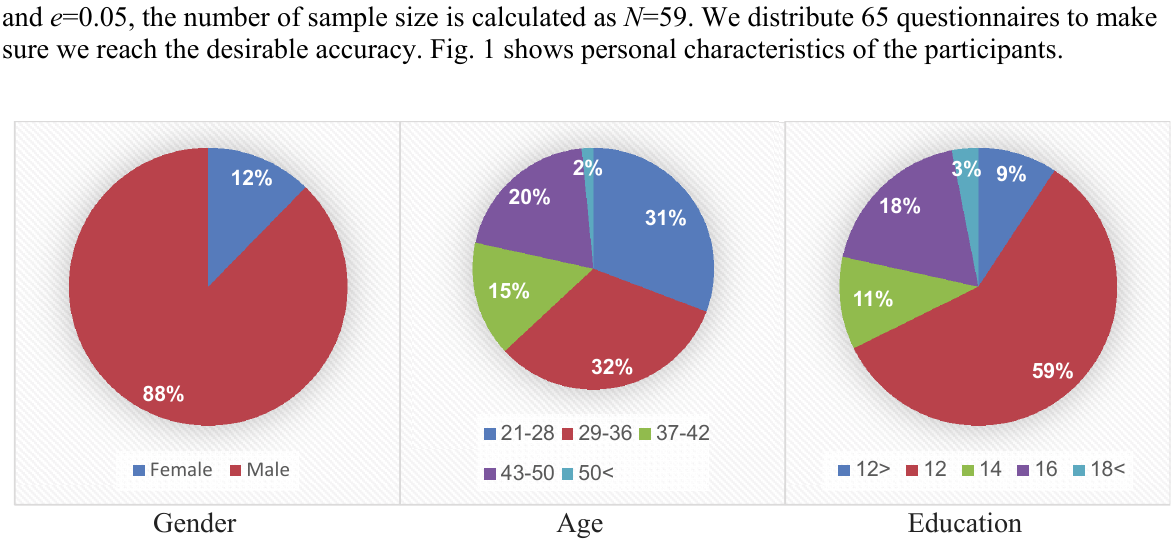
Fig. 1. Personal characteristics of the